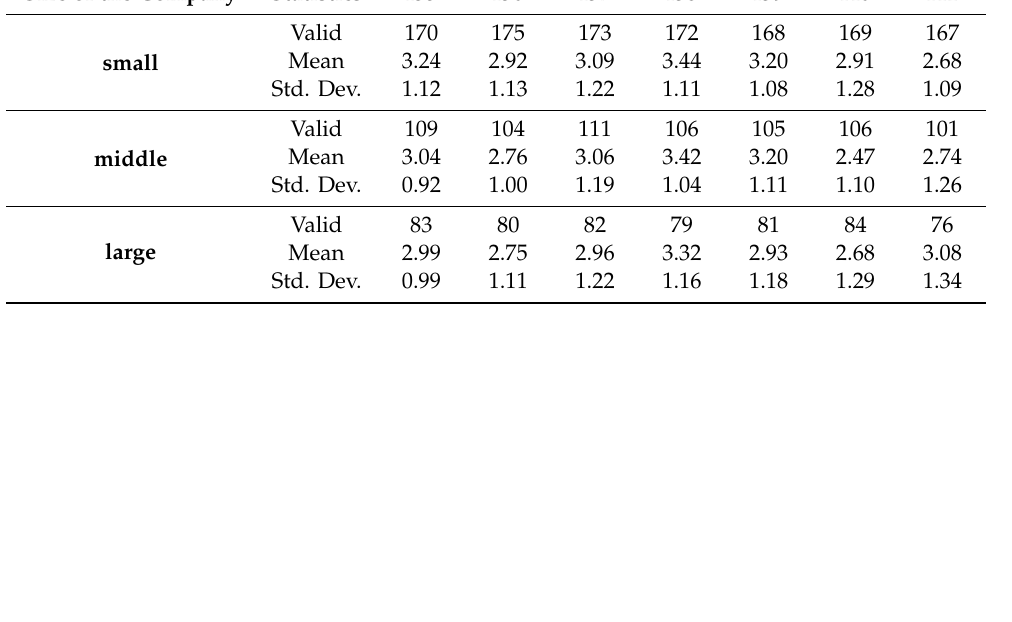
Table 13. Average scores of items in the phase of retaining of talents according to size of the company. Size of the